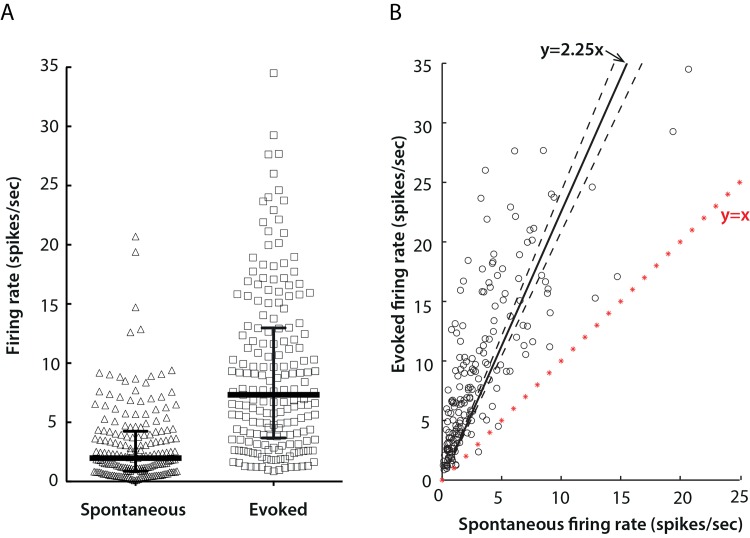
Spontaneous and evoked firing rates of mouse LGN neurons.A) Distributions of spontaneous (triangle) and evoked (square) firing rates of single cells. Solid lines show medians with interquartile ranges; the medians were 2.0 spikes/sec and 7.3 spikes/sec for spontaneous and evoked firing rates respectively. The horizontal position of data points is for clarity in showing the distribution, and conveys no further meaning. B) Correlation of spontaneous (x) and evoked (y) responses. The red line marked with stars represent y = x. Solid line shows the least squares best-fit line, y = 2.25x, and dashed lines the 95% confidence interval 2.08–2.42. R2 = 0.31.